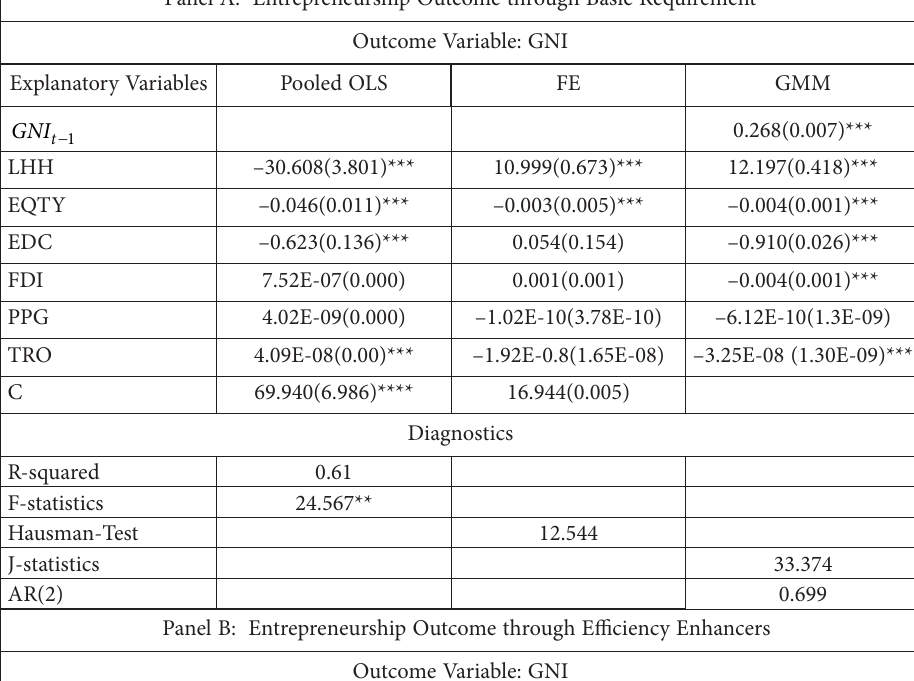
Table 4. Entrepreneurship channels and entrepreneurship outcomes (source: authors’ computation) Panel A: Entrepreneurship Outcome through Basic